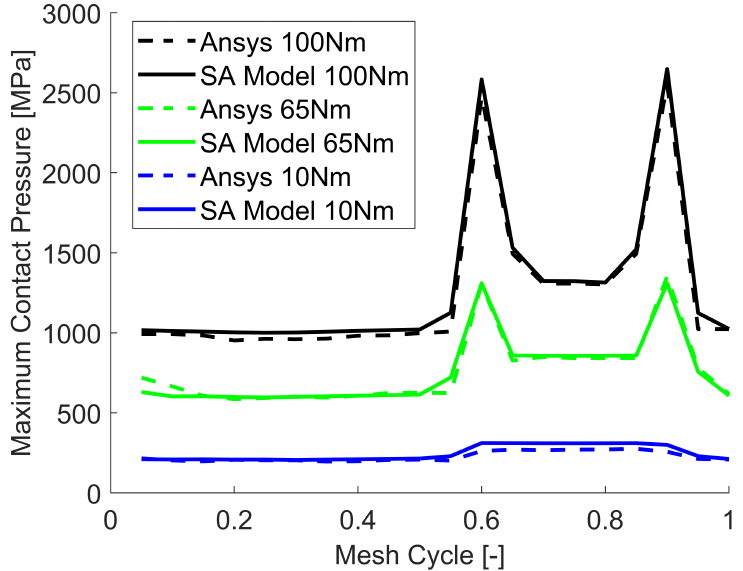
Figure 13. Comparison of the maximum pressure obtained from the SA model and